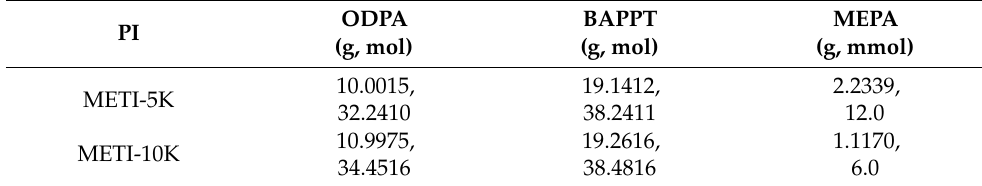
Table 1. Formula for the METI-5K and METI-10K